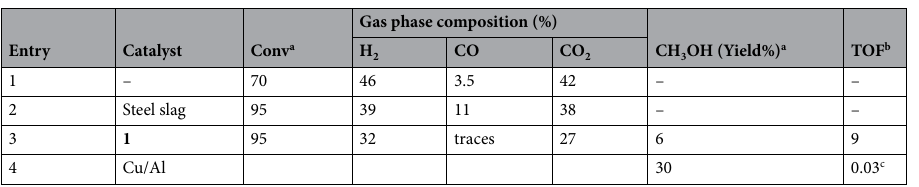
Table 2. Thermal decomposition of formic acid. Reaction conditions: 100 mL of Formic acid 0.44 M, catalyst (as reported in experimental section), T (250 °C), t (6 h). a Conversions and yields were determined by GC analyses using calibration curves. b TOF evaluated as mmol of HCOOH converted/mmol of cath. Pd amounts on surface was determined using EDX elemental analysis. c Reaction conditions: 2.61 HCOOH mmol, 12 mmol Cu/4.4 mmol Al at 300 °C, 9 h 34